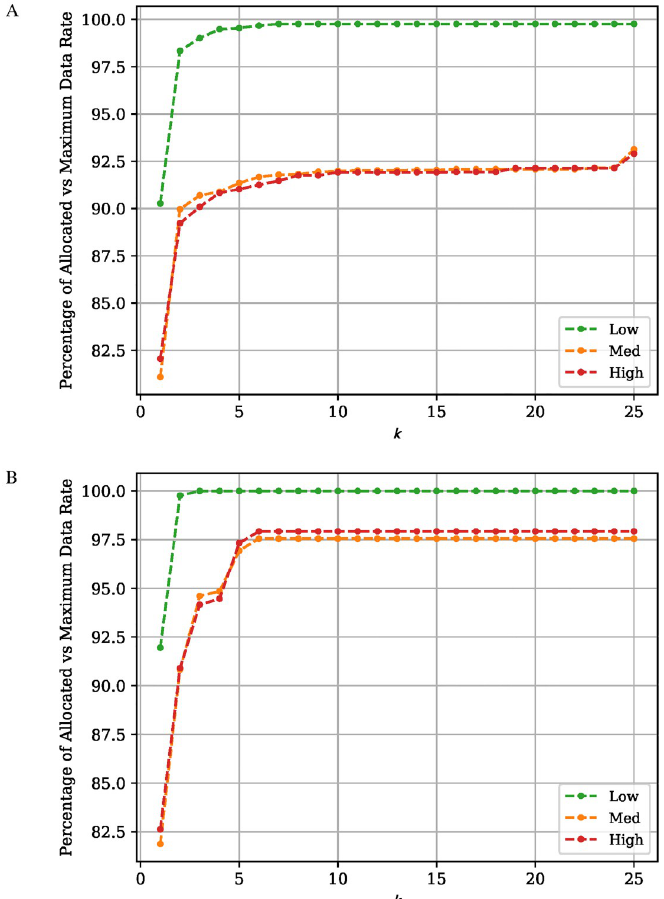
Fig 6. Allocated data rate for constrained vs unconstrained MFMC. Percentage of the Allocated Data Rate when solving the PC-MFMC problem compared to the unconstrained Maximum Flow problem, with varying k . Solutions to both problems is found using LP. All five flow sets for a given network load and the highest number of flows for a given network load are used; 300 Flows for the Low and Medium network flow, and 150 flows for the High network load. A: Path Selection Algorithm: KSP. B: Path Selection Algorithm: